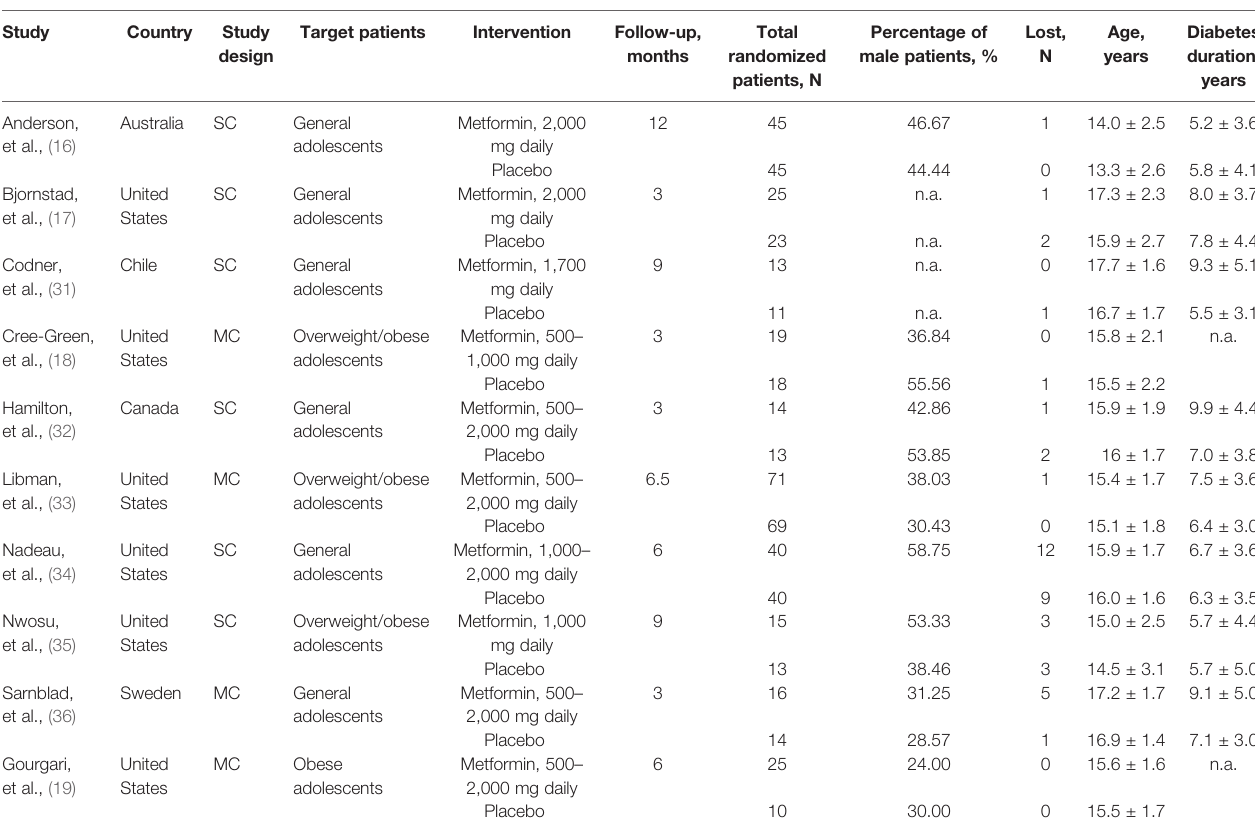
TABLE 1 | Basic characteristics of 10 eligible studies.